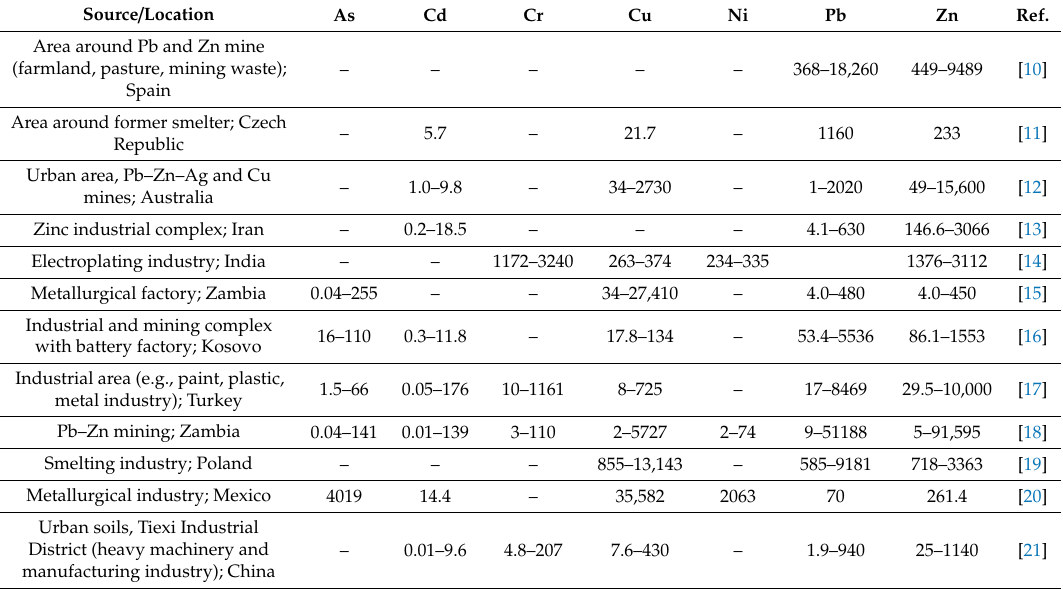
Table 1. Ranges of heavy metal (HM) concentrations in soils (in mg / kg) in selected countries. Source / Location As Cd Cr Cu Ni Pb Zn